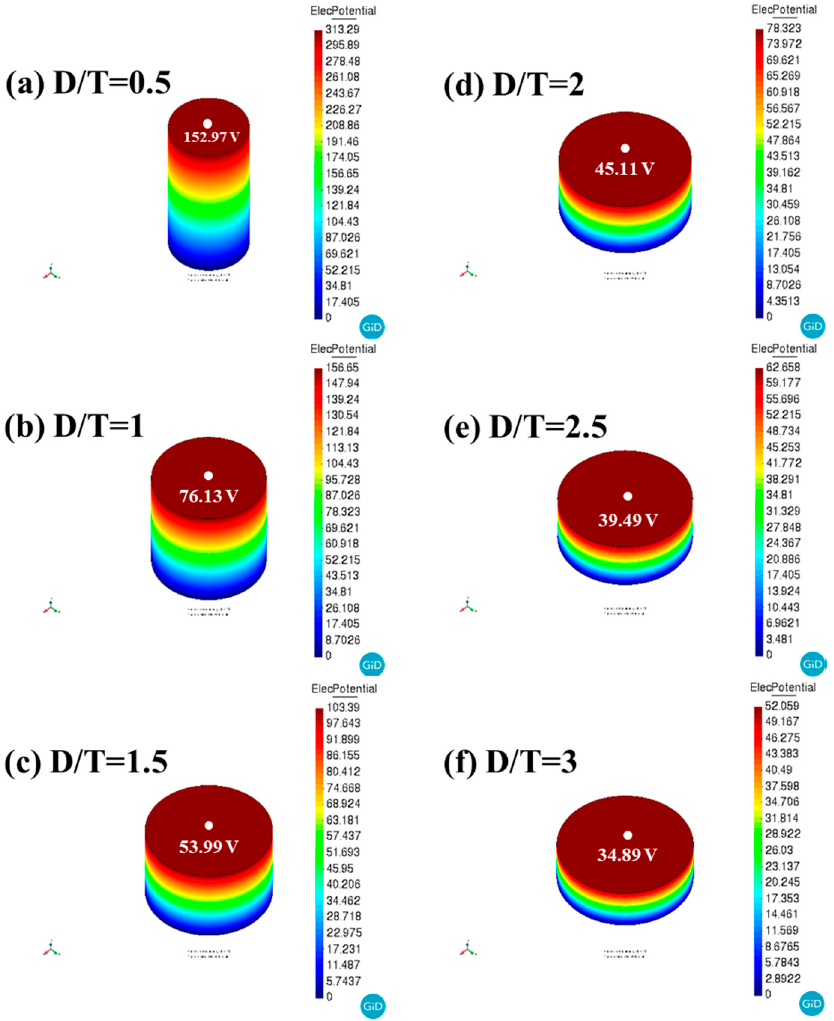
Figure 5. Output voltages of BZT–BCT ceramics in ATILA simulation vs. the D/T ratio. Figure 6a,b shows the piezoelectric charge coefficient ( d 33 ) and voltage coefficient ( g 33 ) of BZT–BCT ceramics vs. the D/T ratio, respectively. As shown in Figure 6a, the piezoelectric charge coefficient ( d 33 ) increased until D/T = 1.5, and then decreased. The BZT–BCT ceramic with a D/T ratio of 1.5 attained the highest piezoelectric charge coefficient of 377 pC/N. In Figure 6b, the piezoelectric voltage coefficient ( g 33 ) tended to decrease when the D/T ratio was higher than 1. The BZT–BCT ceramic with a D/T ratio of 1 attained the high- est piezoelectric voltage coefficient ( g 33 ) of 11.38 × 10 − 3 Vm/N. The piezoelectric voltage coefficient indicates the electric field that the piezoelectric material can generate when an external pressure is applied: 𝑔 (cid:2871)(cid:2871) = (cid:3031) (cid:3119)(cid:3119) (cid:3084) (cid:3293) (cid:3084) (cid:3116)